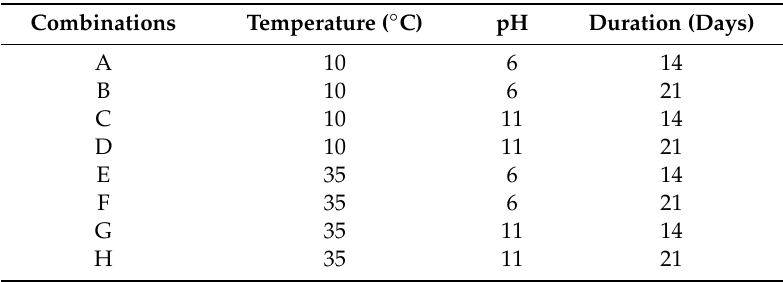
Table 2. Combinations of the design T. harzianum